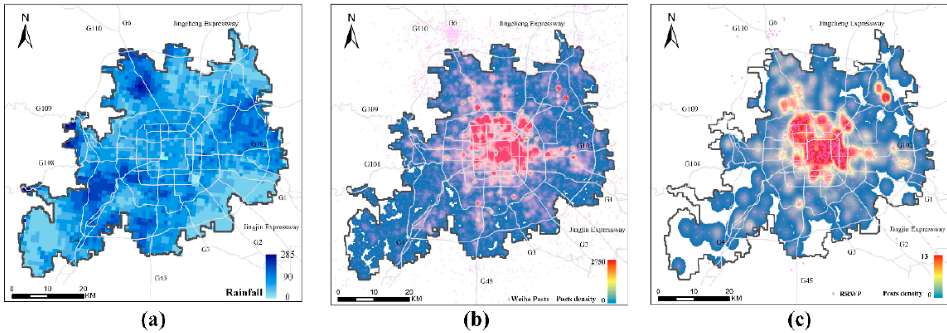
Figure 5. Spatial distribution of the rainfall amount ( a ), the number of Weibo posts ( b ), and the number of RRWP ( c ).